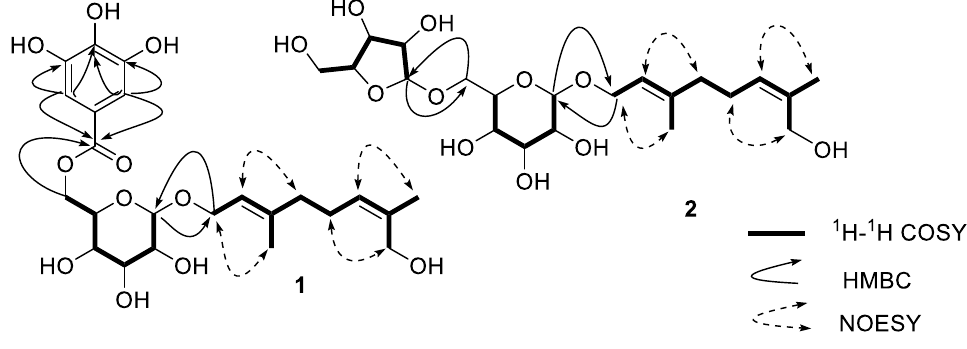
Figure 2. The 1 H- 1 H COSY, key HMBC and key NOESY correlations of 1 – 2 .